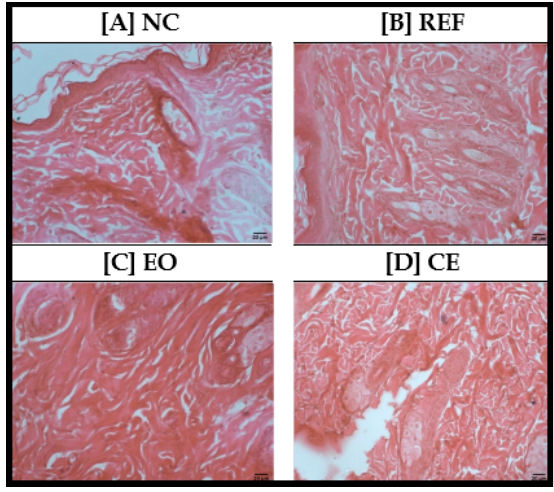
Figure 6. Histological sections of the wound tissue of rats after topical application of cream base ( A ), Fucidin cream ( B ), EO cream ( C ), and CE cream ( D ). H&E stain, magnification: ×400.